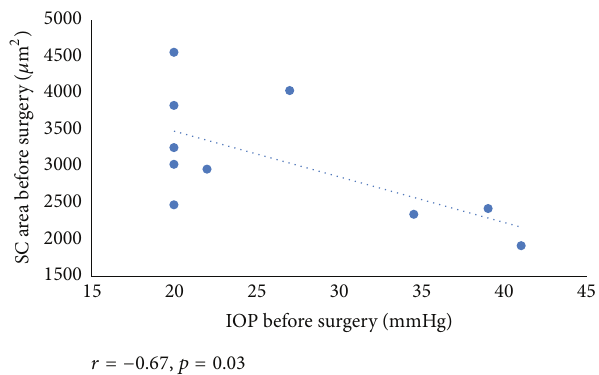
Figure 4: Scattergram showing the relationship between the SC area and IOP before surgery.